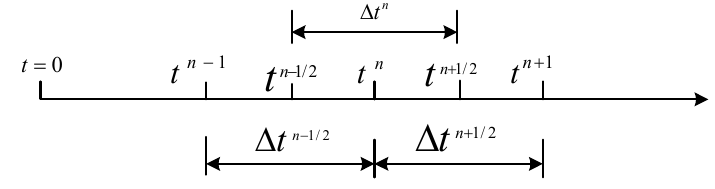
Figure 1: Timeline of central difference